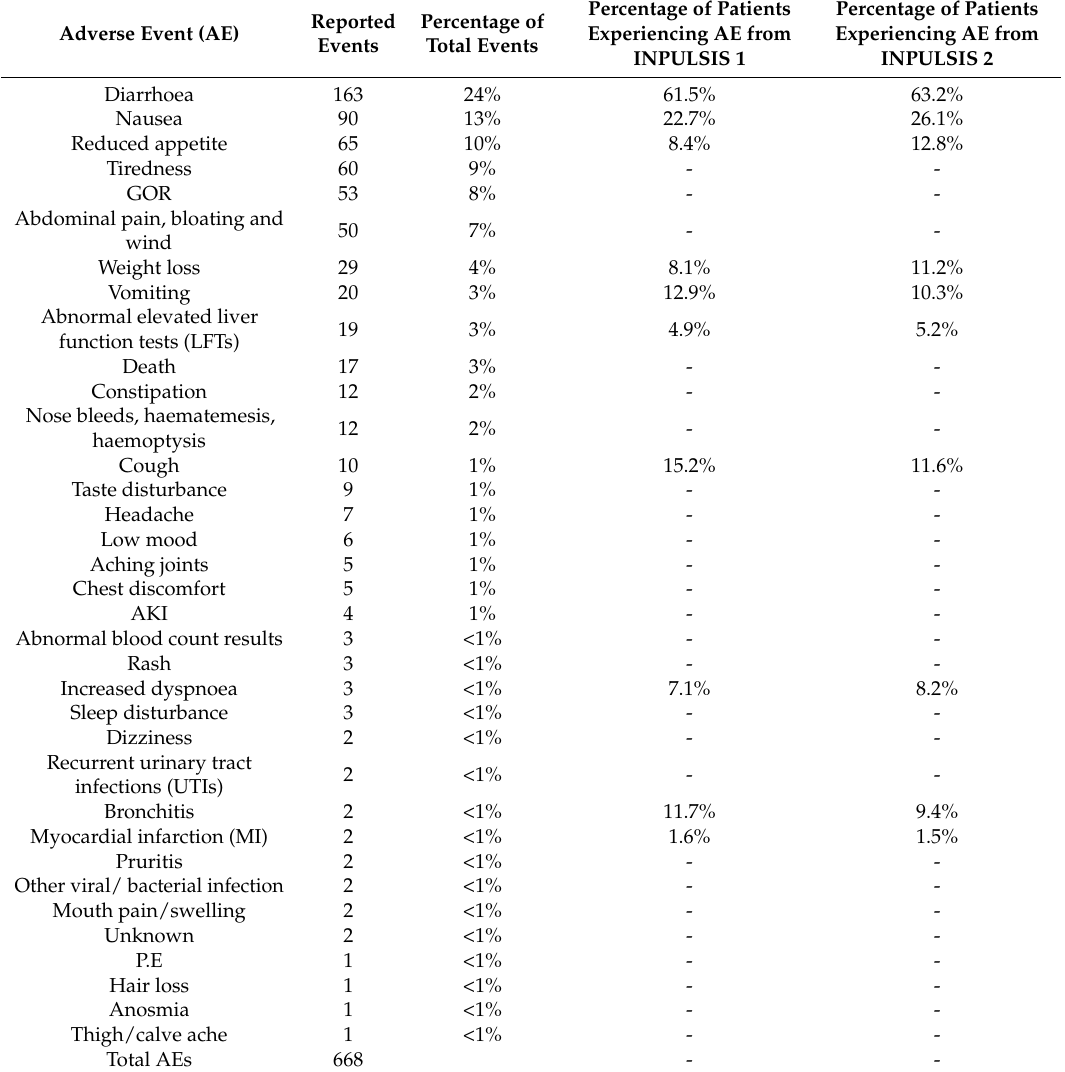
Table 2. Frequency of Adverse Events with Nintedanib Compared to INPULSIS Clinical Trials.